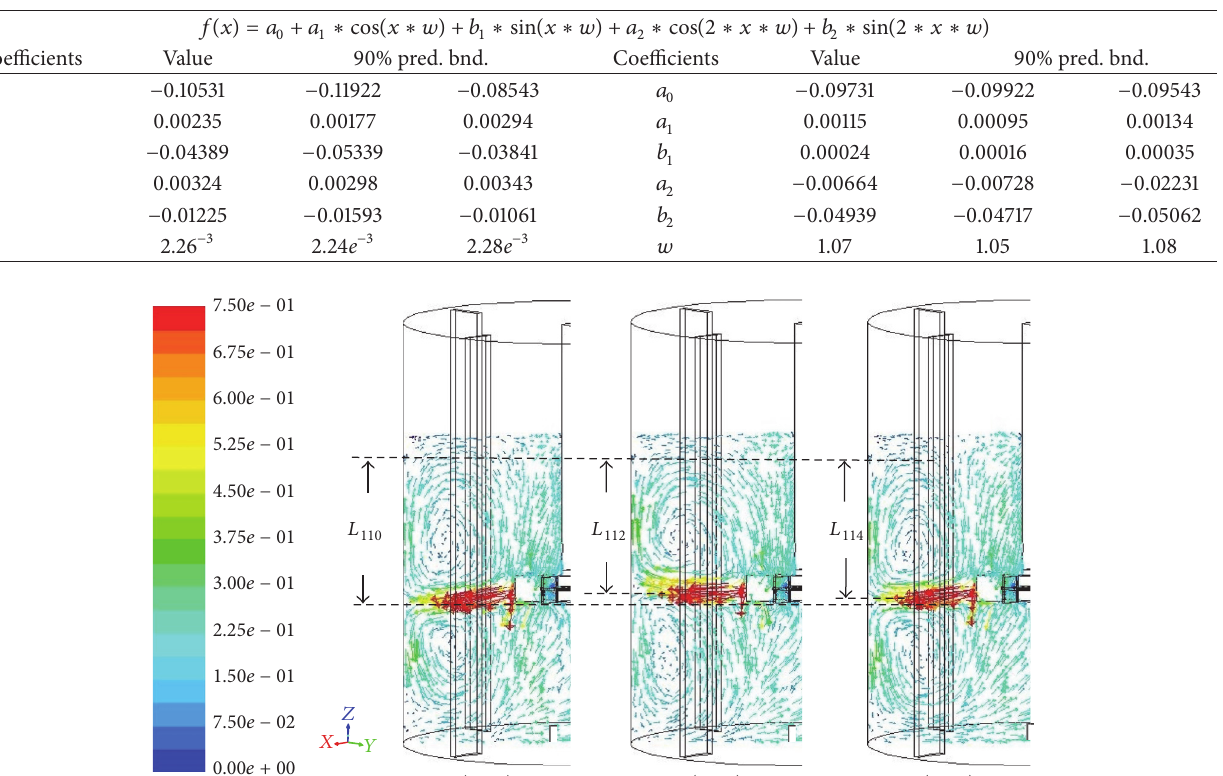
Figure 4: Liquid velocity vector diagrams (in m/s) on the plane ( 𝑟/𝐷 𝑟 = − 0.5 ∼ 0.5, z/ 𝐷 𝑟 = − 0.5 ∼ 0.5, and 𝜃 = 45 ∘ ), 𝑁 = 250 rpm.